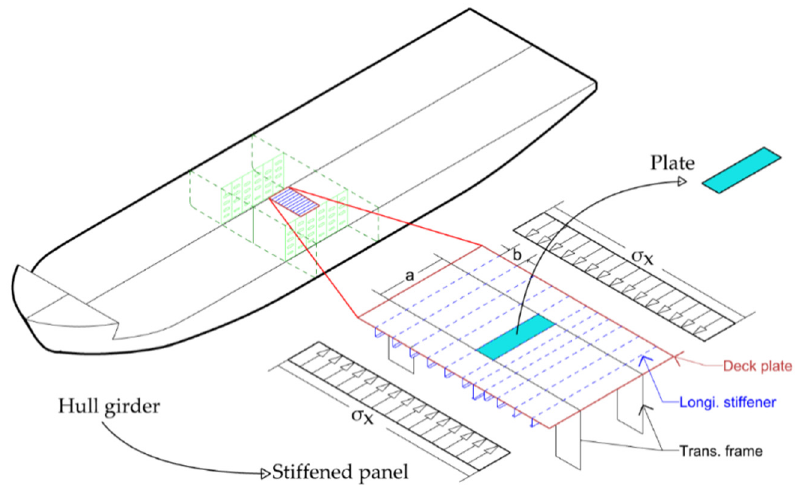
Figure 5. Schematic view of different levels of ship structures.